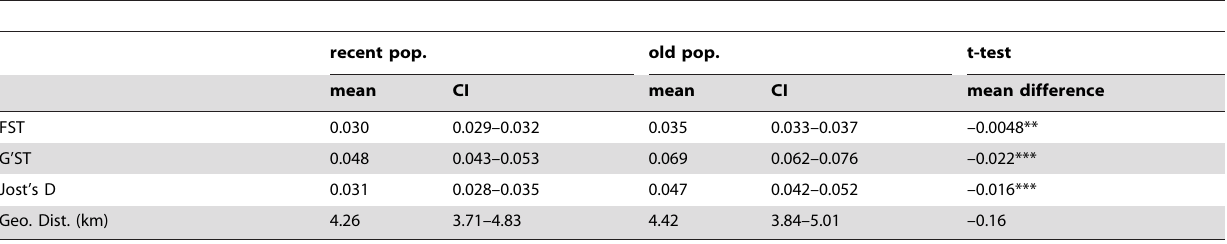
Table 3. Parameter estimates of performed bootstrapping analysis on pairwise differentiation for recent and old populations and differences between recent and old populations tested based on bootstrap t-tests.